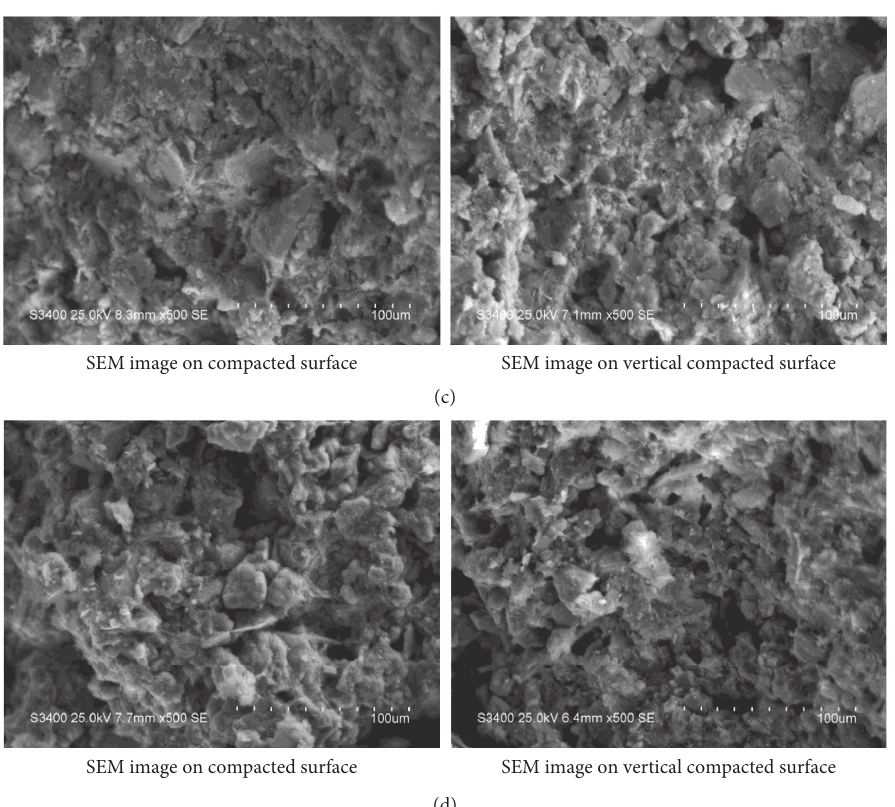
Figure 10: SEM images with different dry densities (500 times) [4]. (a) ρ (d) ρ d � 1.40 g/cm 3